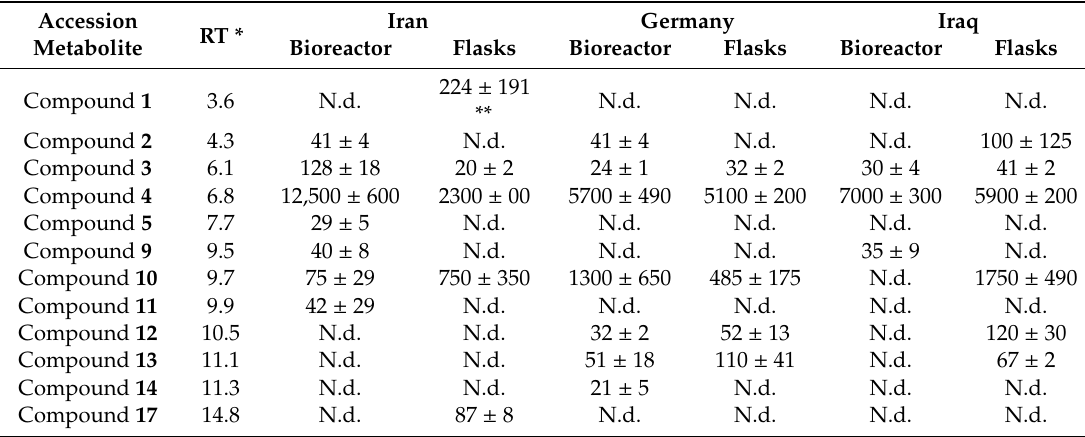
Table 3. Exudatesofhairyrootsof Hyoscyamusniger collectedinbioreactorandflaskcultures. Theexudates were analyzed by HPLC-ELSD. Only metabolites present in all three replicates were